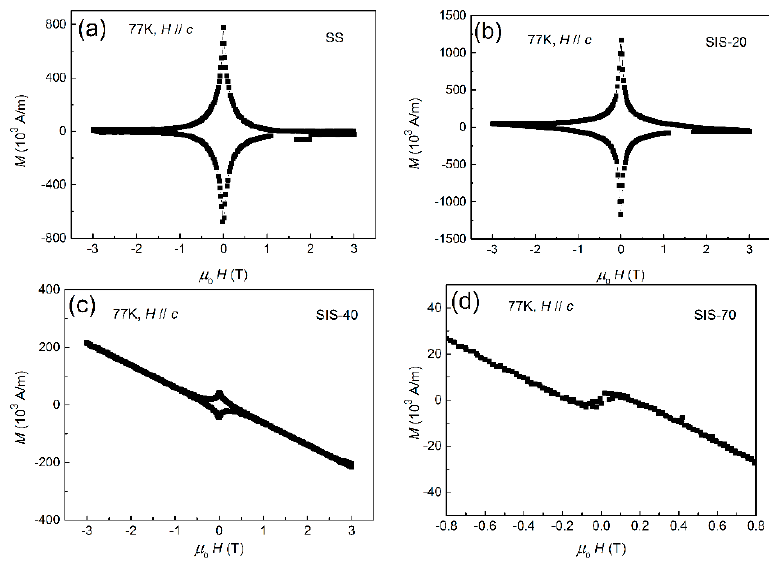
Figure 2. The M-H curves of the YBCO / LAO / YBCO trilayer with LAO thicknesses of ( a ) 0, ( b ) 20, ( c ) 40, and ( d ) 70 nm.